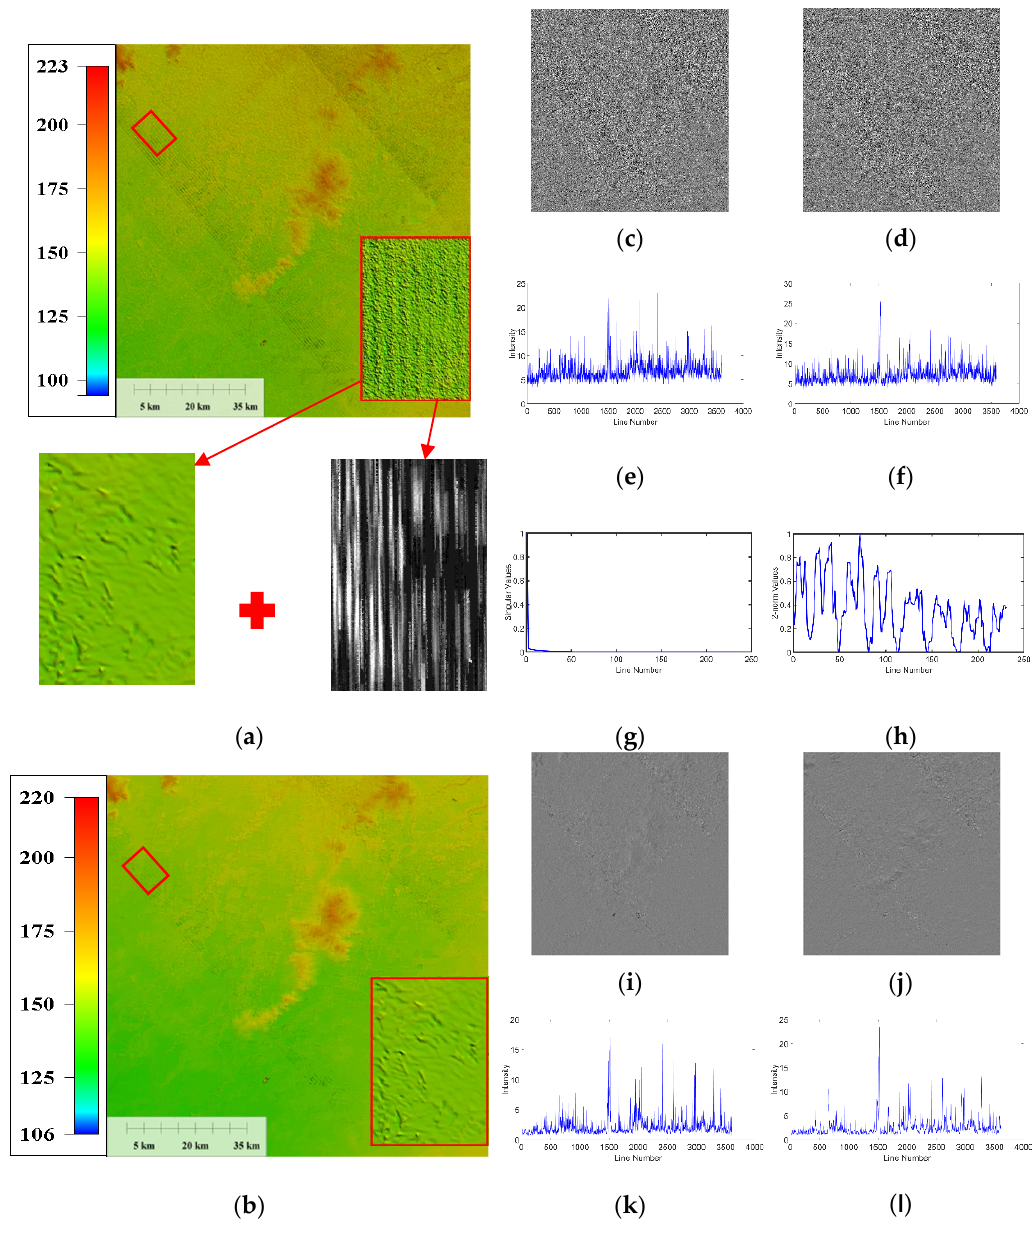
Figure 4. Analyzing the gradient decomposition in this experimental area (unit: meter), Mixed noise interferes with data in both gradient directions. The stripe structure in the local range is similar to the line structure, so the rank of the matrix is near 1, and the 2-norm values in the striped column and the unstriped column in the local region have obvious peak-to-valley contrasts. ( a ) The original Data, local data and mixed errors magnification, ( b ) processed data, ( c ) horizontal gradient of original data, ( d ) vertical gradient of original data, ( e ) gradient intensity of c, ( f ) gradient intensity of d, ( g ) statistics of local mixed errors singular values in a, ( h ) 2-norm statistics of local mixed errors in a, ( i ) horizontal gradient of b, ( j ) vertical gradient of b, ( k ) gradient intensity of i and ( l ) gradient intensity of